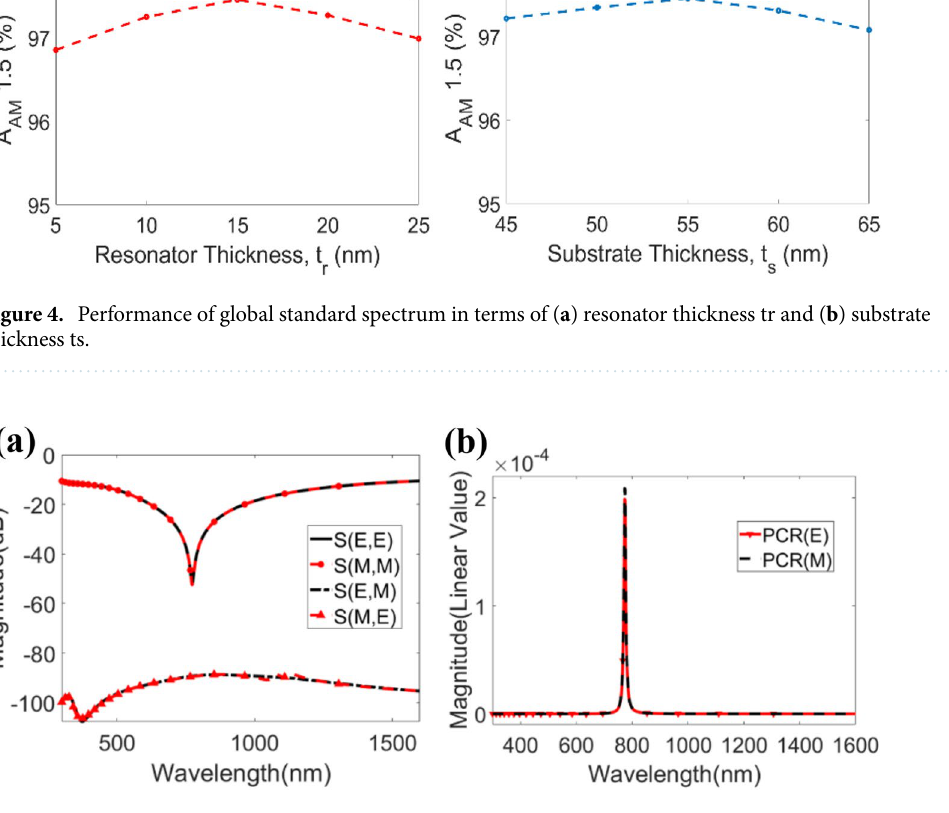
Figure 5. ( a ) Demonstration of co-polarization and cross-polarization, and ( b ) PCR of the structure in both TE and TM